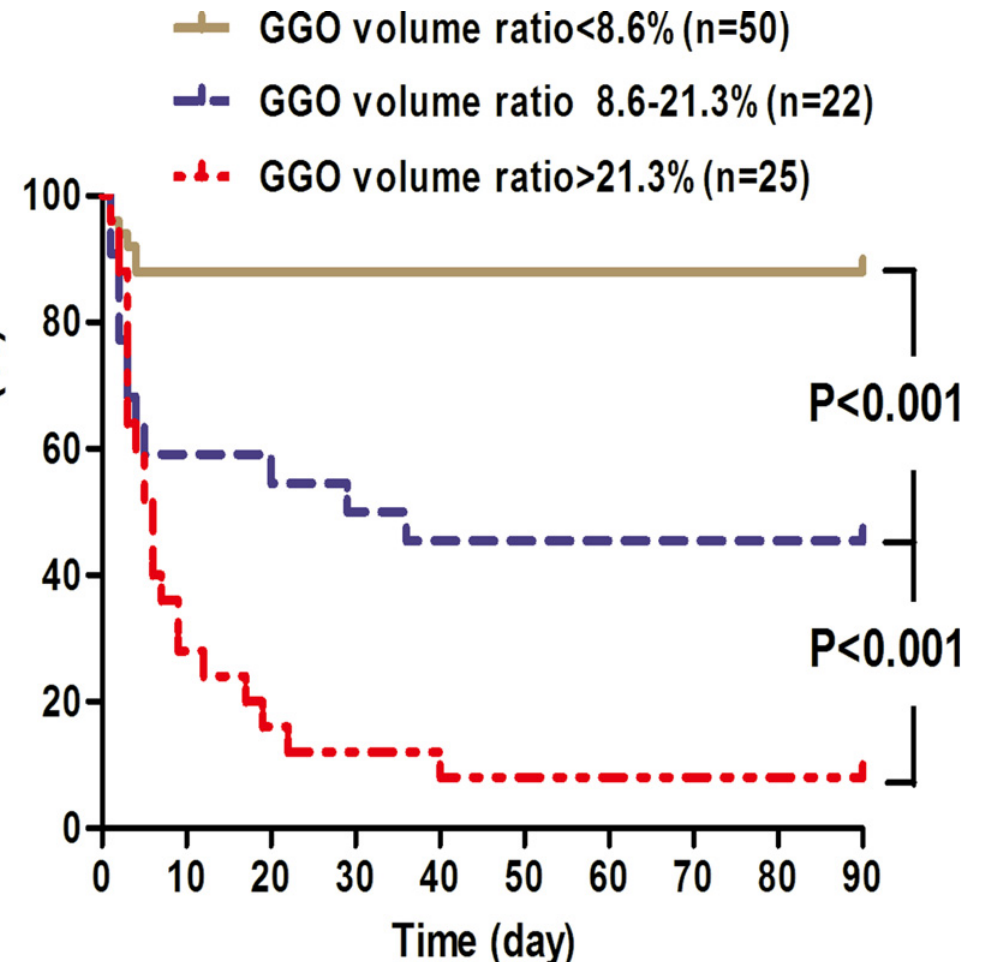
Fig 5. Kaplan-Meier survival curves of 97 paraquat poisoned cases stratified according to levels of GGO volume ratios within the first 5-day period. Patients were categorized into three groups based on quartile levels of GGO volume ratios. Comparisons between curves showing difference with statistical significance (P < 0.05) are